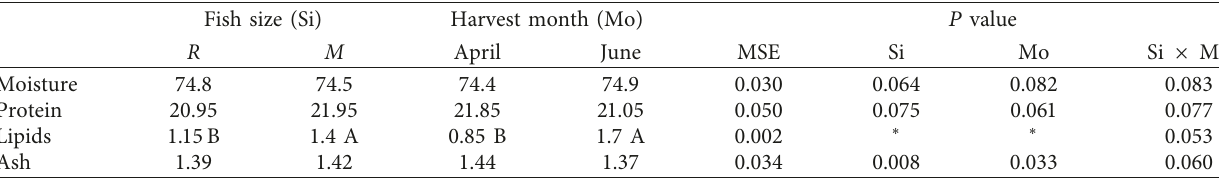
Table 2: Proximate composition (% wet weight basis) of fillet of ABF gilthead sea bream according to fish size and harvest month. Fish size (Si) Harvest month (Mo) Moisture Lipids 1.15B Ash